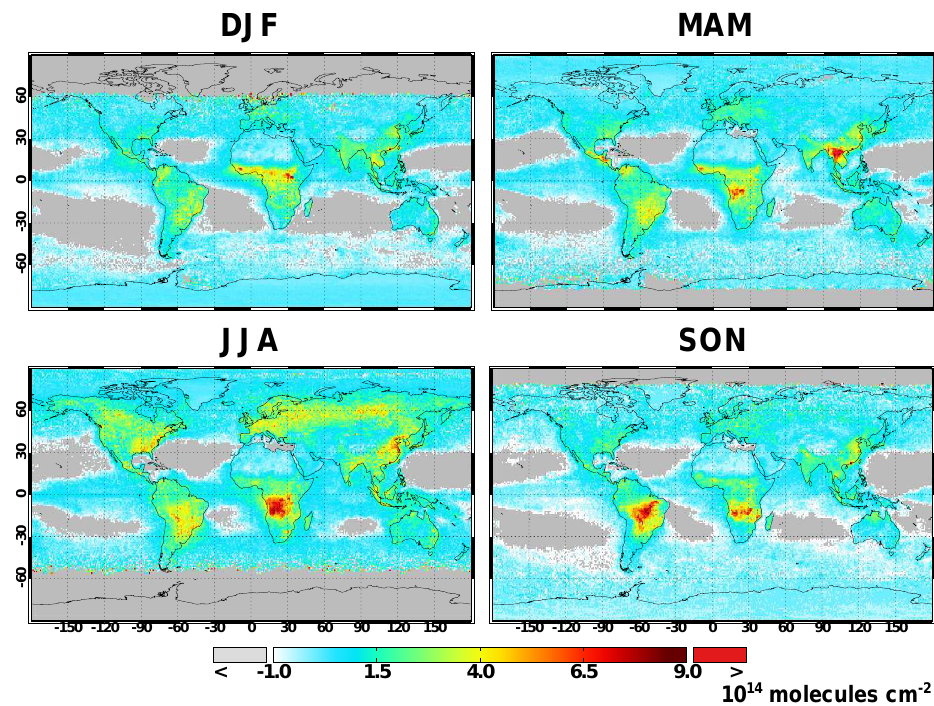
Figure 15. Seasonally averaged glyoxal VCDs (moleculescm − 2 ) retrieved from OMI for 2007.